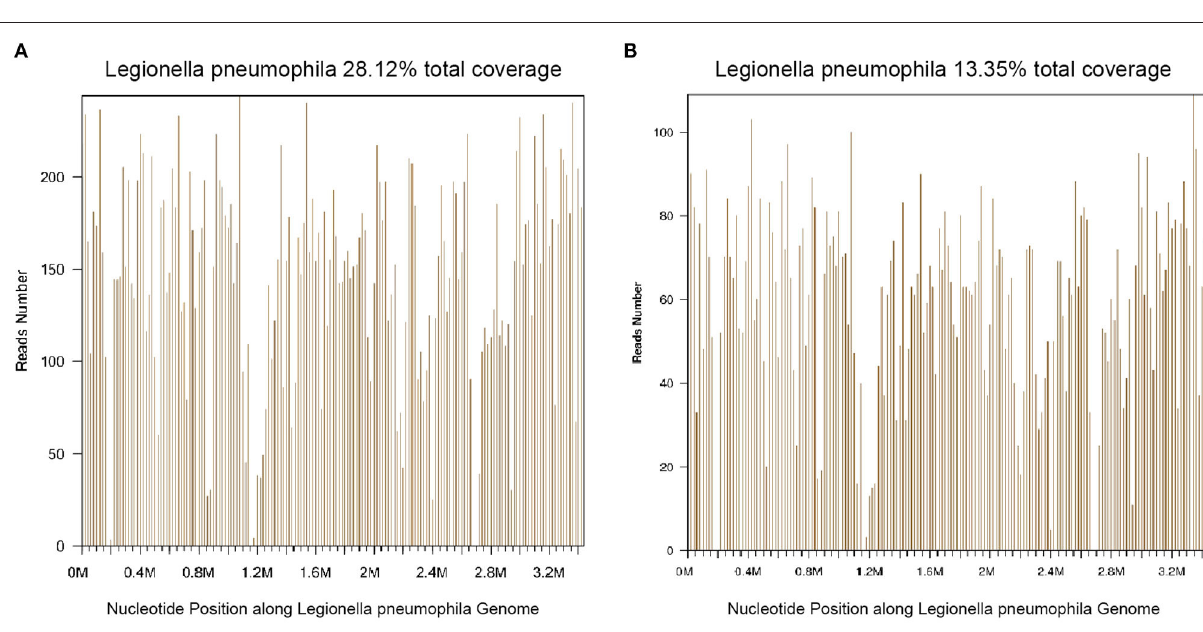
FIGURE 3 | Diagnosis of Legionella pneumophila infection using mNGS. (A) The majority of reads mapped to the L. pneumophila genome with coverage of 28.12%. (B) The majority of reads mapped to the L. pneumophila genome with coverage of